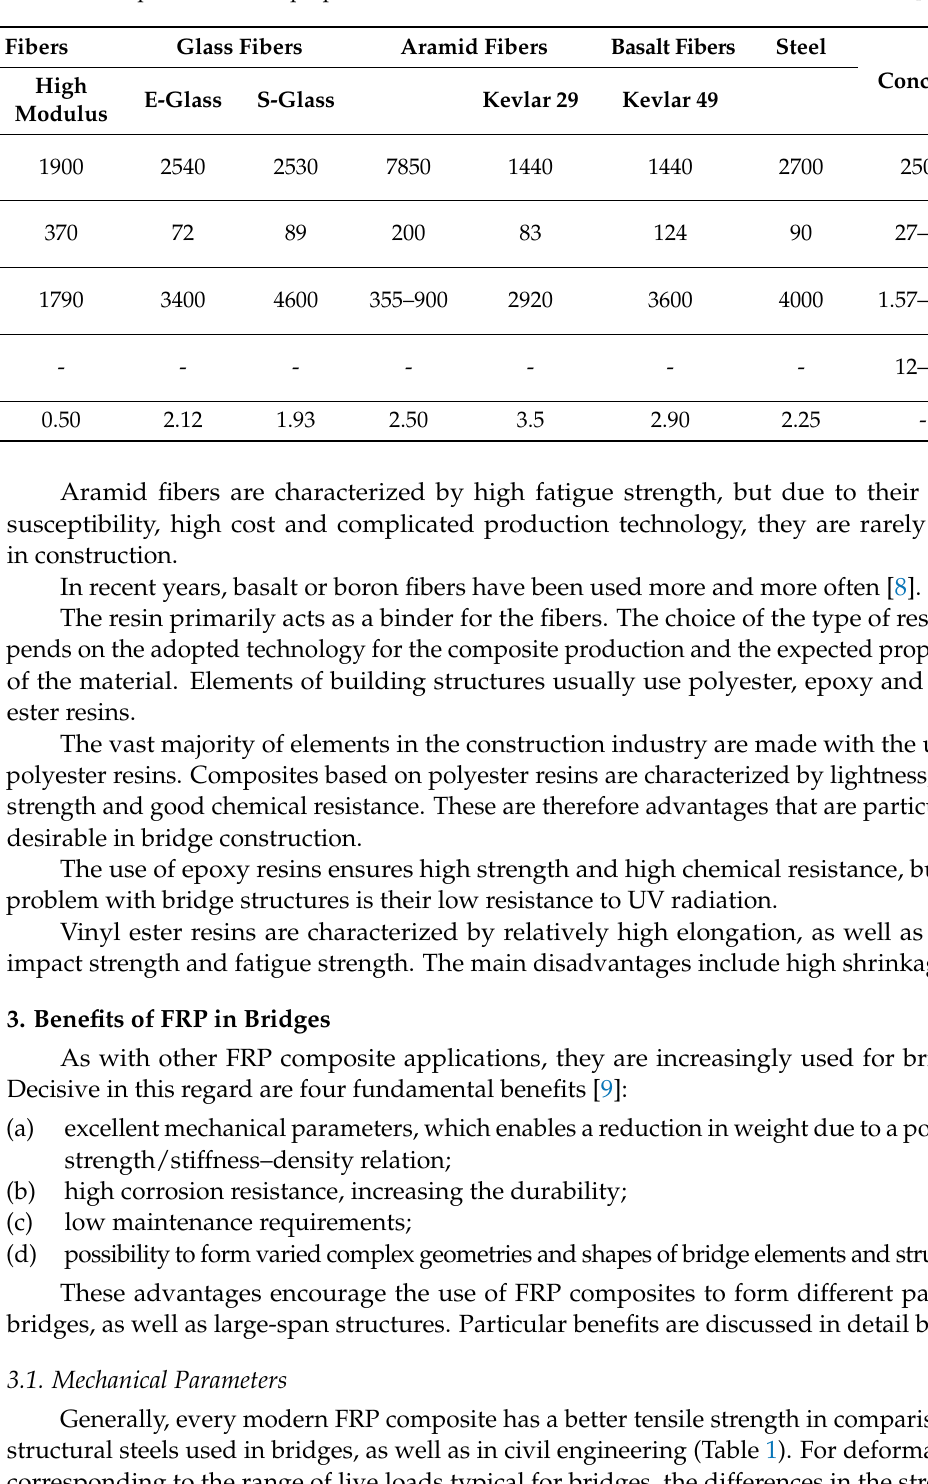
Table 1. Comparison of basic properties of different kinds of fibers, concrete and structural steel